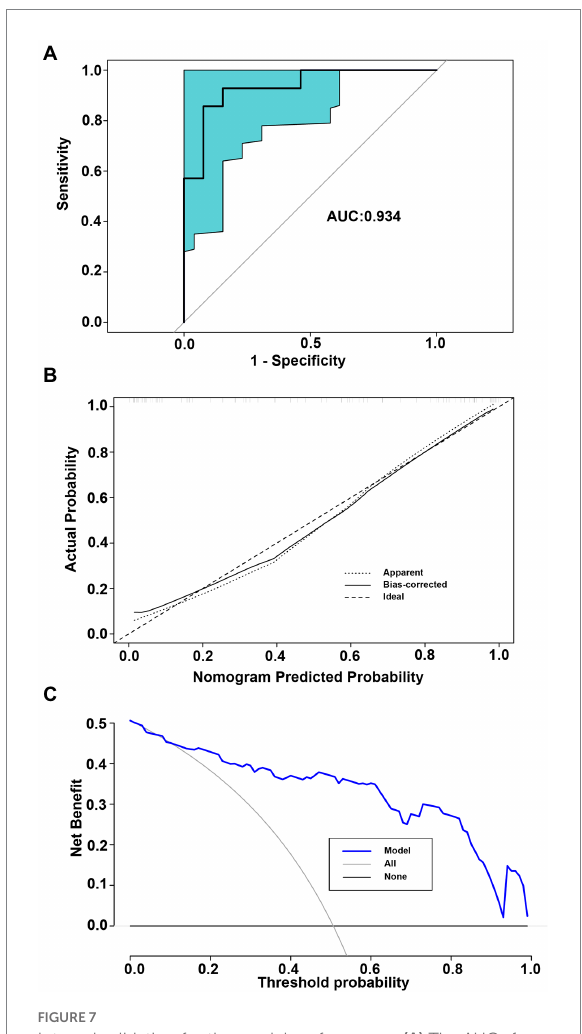
FIGURE 7 Internal validation for the model performance. (A) The AUCs for stratified K-fold cross-validation ( K = 3). (B) Calibration curves of the nomogram for predicting probability of developing STEMI. The x-axis represents the nomogram-predicted probability, whereas the y-axis represents the actual probability. (C) Net benefit of using a model to diagnose STEMI compared with the strategies of “treating all” or “treating none” for different decision